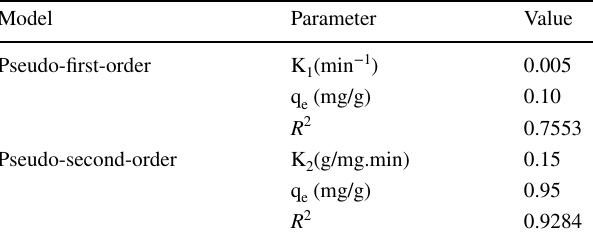
Fig. 4 The plots of pseudo-first-order model ( a ) and pseudo-second-order model ( b ) Table 6 Result of AG 20 kinetic onto HDTMA-Sep